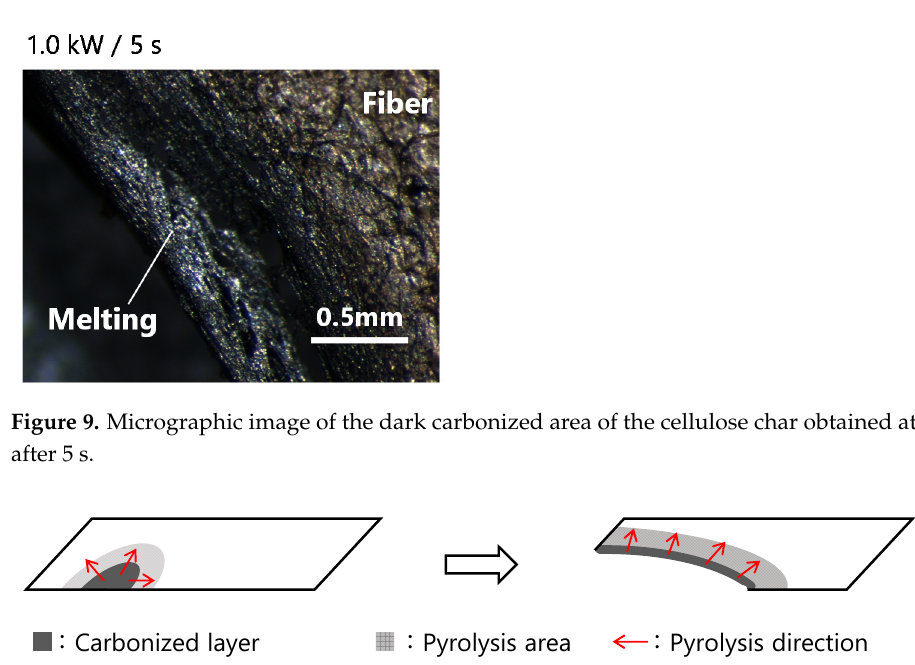
Figure 10. A diagram showing the process occurring during the fast pyrolysis of a Whatman cellulose sheet under IR irradiation.